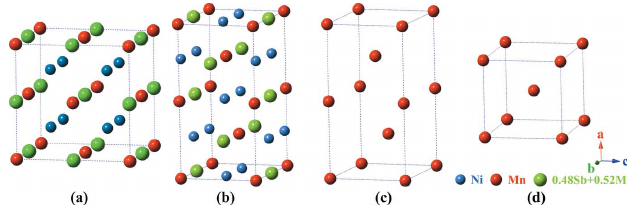
Figure 4 The crystal structures of ( a ) cubic austenite, ( b ) 4 O modulated martensite and ( c ) simplified 4 O modulated martensite. ( d ) The average unit cell of the 4 O modulated martensite.